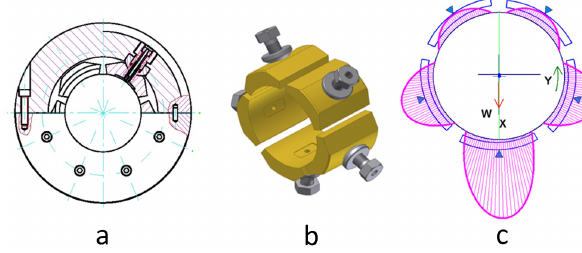
Figure 4: Hybrid bearing, a) design, b) 3D model of bearing pads with their supply system, c) pressure distribution in the bearing clearance